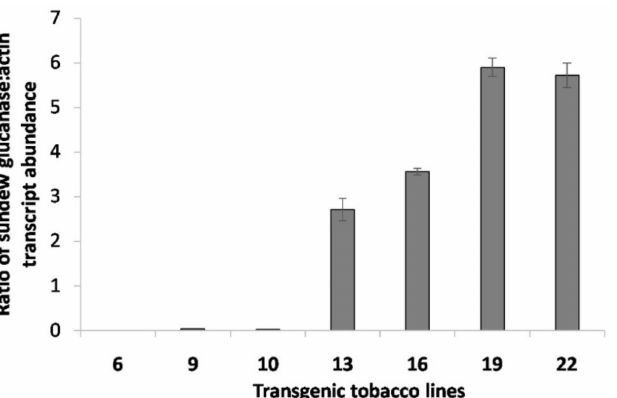
Figure 4. Relative expression levels of the DbGluc1 gene in transgenic tobacco lines. Relative expression levels were calculated with the Pfaffl method as the ratio between transcript abundance of the target DbGluc1 transgene and the endogenous actin gene control. Normalisation was performed based on the amplification efficiency results from a 5 point 5-fold dilution standard curve (DbGluc1: E = 1.813, R 2 = 0.999; actin: E = 1.854, R 2 = 0.998). Error bars are standard deviations calculated from three independent biological samples, each with technical